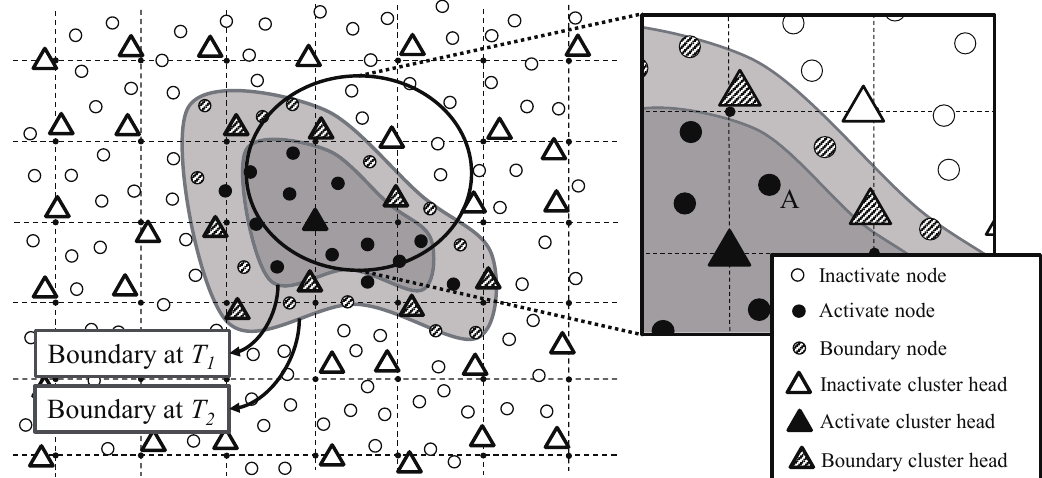
Figure 11. Boundary detection and tracking in OCOT.